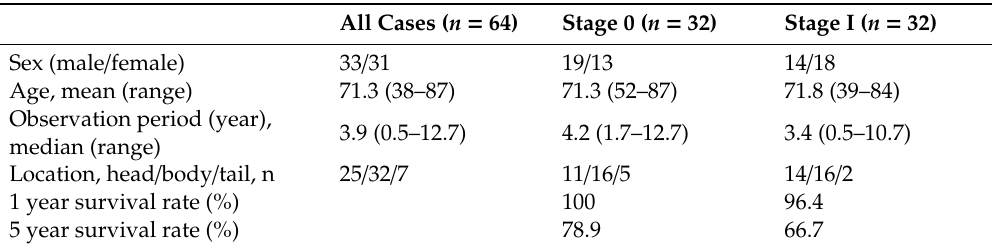
Table 2. The clinical characteristics of stage 0 and stage I